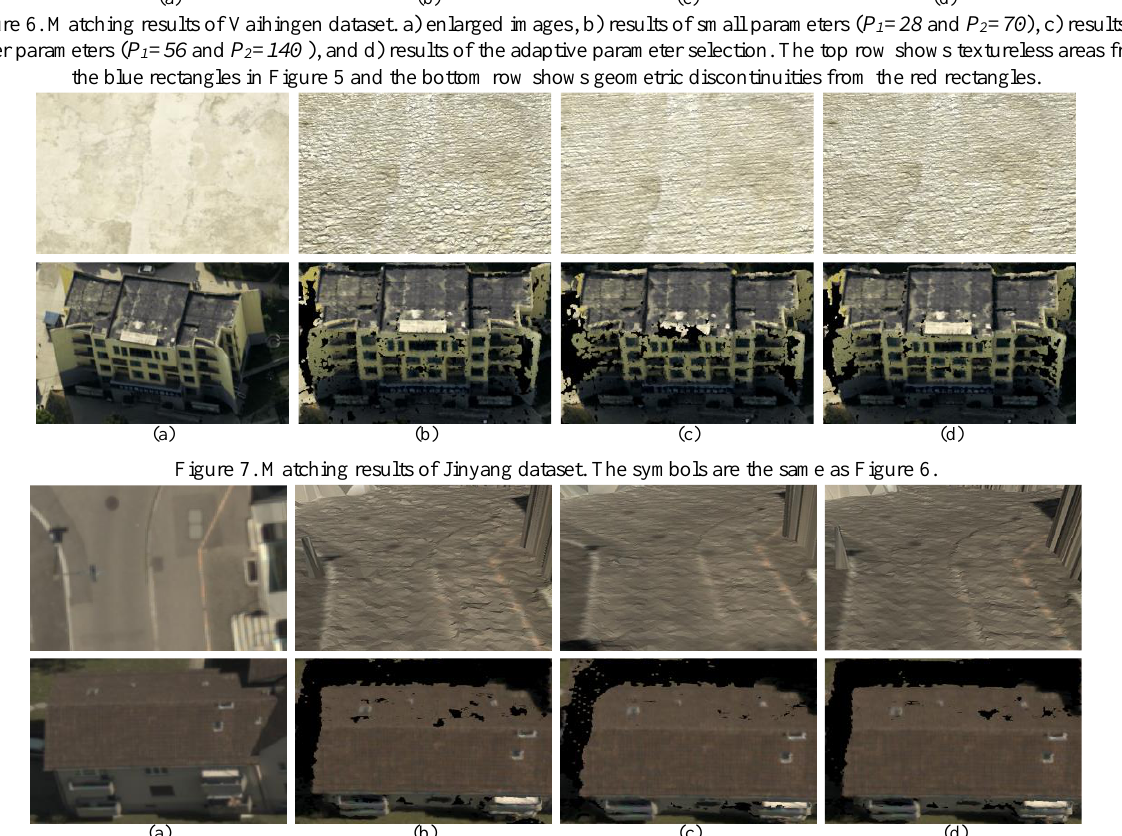
Figure 8. Matching results of Zurich dataset. The symbols are the same as Figure